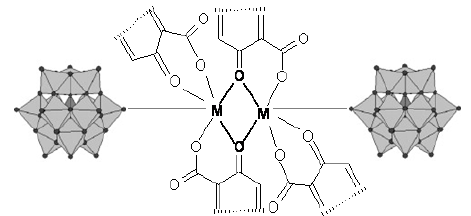
Figure 8. A binuclear metallic cluster of quinolone bound to POM clusters.